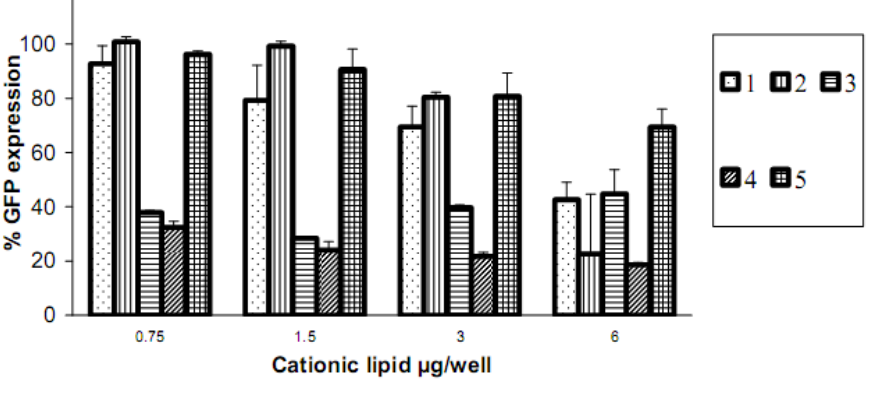
Figure 4. Reduction in GFP expression in HeLa cells after transfection with lipoplexes of fatty acid amides of spermine at different cationic lipid/siRNA ratios. siRNA concentration is kept constant at 15 pmol/well. Values are presented as mean ± SD (n = 6).